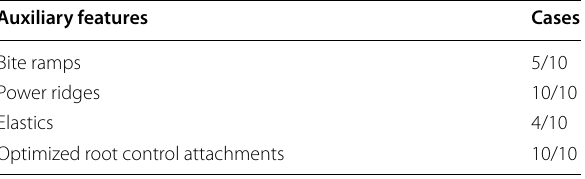
Table 2 Use of auxiliary features within participants’ treatments